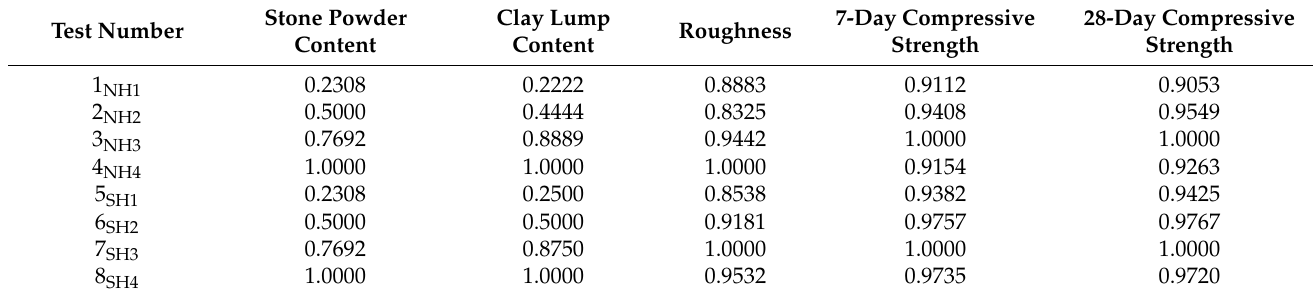
Table 11. Initialization